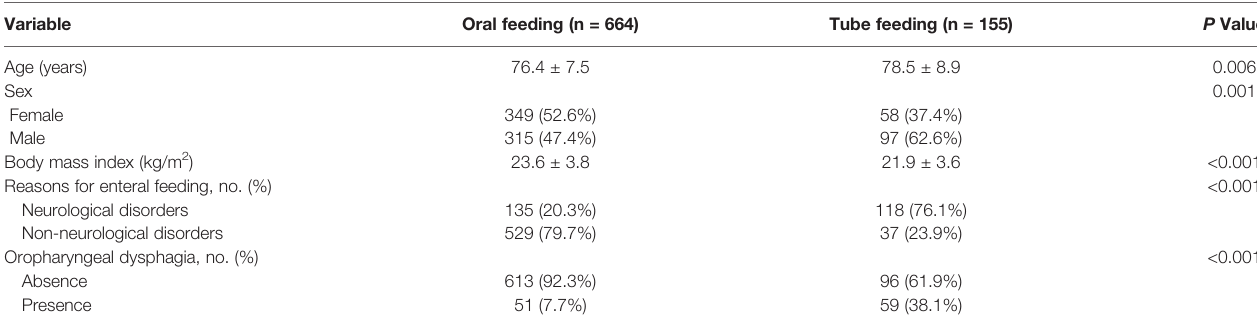
TABLE 1 | Patients